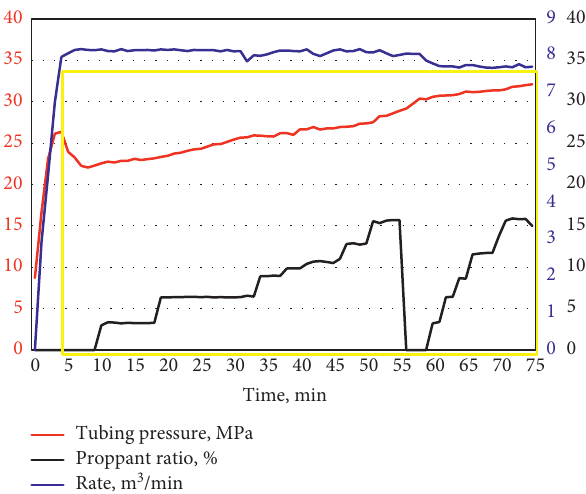
Figure 6: The rise of the black line shows the sensitivity to proppant ratio.